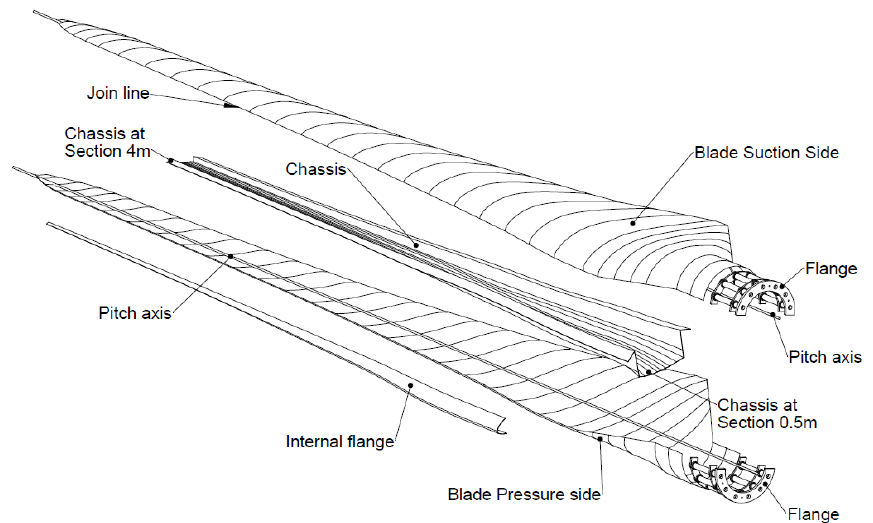
Figure 1. Blade assembly for the 5m RÜZGEM turbine blade (Philippidis and Roukis,